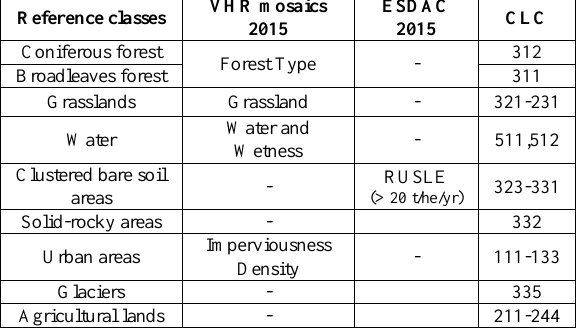
Table 1. Input datasets for the training layer and the translation to the reference